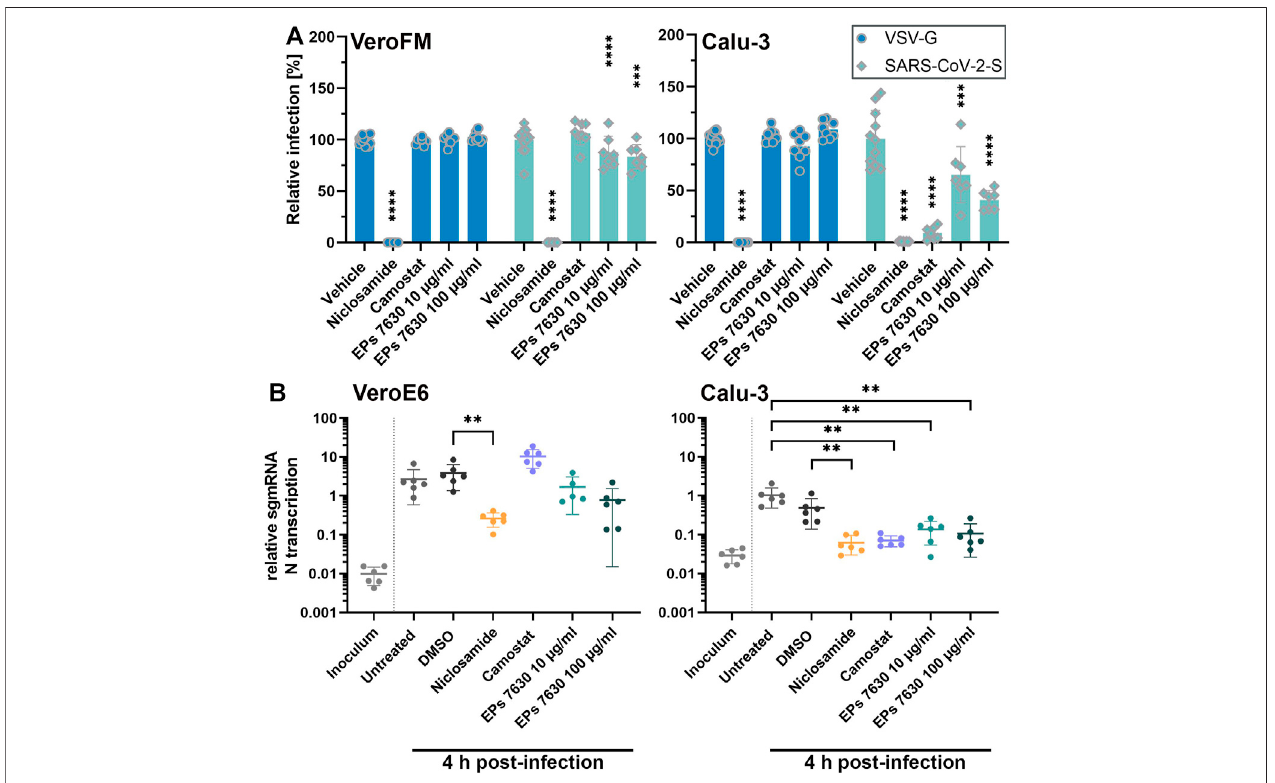
FIGURE 2 | EPs 7630 inhibits entry of VSVpp-SARS-CoV-2-S and SARS-CoV-2 in TMPRSS2-negative VeroFM and TMPRSS2-positive Calu-3 cells. Cells were pre-treated with the indicated compounds for 2 h pre-infection at 37 ° C. (A) Infection with luciferase-producing VSVpp-SARS-CoV-2-Spike (SARS-CoV-2-S), VSV-G control, or pCG1 vector control was done in the presence of compounds for 30 min at 4 ° C at 300 × g followed by 1.5 h incubation at 37 ° C to achieve synchronous infection.Themediumwasthenreplacedbycompound-containingDMEMasindicated.Ascontrols,weapplied10 µMniclosamide(endosomalentryblocker)and 10 µMcamostatmesylate(TMPRSS2inhibitor).Celllysateswerepreparedafter16 h(VeroFM)or24 h(Calu-3)andluminescencewasmeasuredusingamulti-mode96- well plate reader. Bars represent mean values and SD from at least n (cid:2) 7 biological samples from two independent experiments. Vehicle (cid:2) DMSO-(niclosamide) or medium (remaining compounds). Statistical signi fi cance (treatment vs. control) is indicated by (*) asdetermined bytwo-way ANOVA with Dunnett ’ smultiple comparison testing. (*) (cid:2) p < 0.05; (**) (cid:2) p < 0.01; (***) (cid:2) p < 0.001; (****) (cid:2) p < 0.0001. (B) VeroE6 and Calu-3 cells were pretreated with the indicated compound 2 h as described in (A) .InfectionwithSARS-CoV-2(MOI (cid:2) 1)wasdonebyincubationfor15 minat4 ° C,followedby30 minat37 ° Ctoachievesynchronizedinfection.Themediumwasthen replaced by compound-containing DMEM as indicated. As controls, we applied 10 µM niclosamide (endosomal entry blocker) and 10 µM camostat mesylate (TMPRSS2 inhibitor). Cell lysates were prepared 4 h post-infection and subgenomic viral mRNA (sgmRNA) was quanti fi ed by RT-qPCR. Data are presented as gene expression relative to the reference gene TBP from n (cid:2) 6 biological samples from 3 experiments. Statistical signi fi cance is indicated by (*) as determined by unpaired t-test. (*) (cid:2) p < 0.05; (**) (cid:2) p < 0.01; (***) (cid:2) p < 0.001; (****) (cid:2) p < 0.0001. DMSO (cid:2) Dimethyl sulfoxide (vehicle for niclosamide).